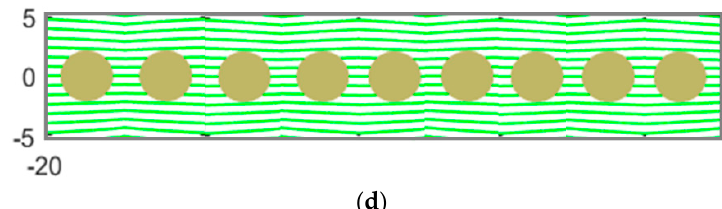
Figure 6. ( a ) Overview of multi-pore flow space showing streamlines. ( b ) Central section of the multi-pore model with the matrix between the pores filled with dark dye. The dimensions of the pores, the strength of the streamlines, and duration of simulation is the same as in Figures 3 and 5. The strength of the pores is 30 times the strength of the far-field flow. ( c ) Flow of passive ganglion (brown body) through the micro-pore network model. Snapshots of passive ganglion are given for 60, 240, 360, and 480 s. ( d ) Continuum model with dyed blob to study the movement of fluid particles would not change shape as in pore network model, and interfacial contact surface or length does not change, unlike that seen in case ( c ) due to deformation in the pore space. Length units are scaled in μ m.